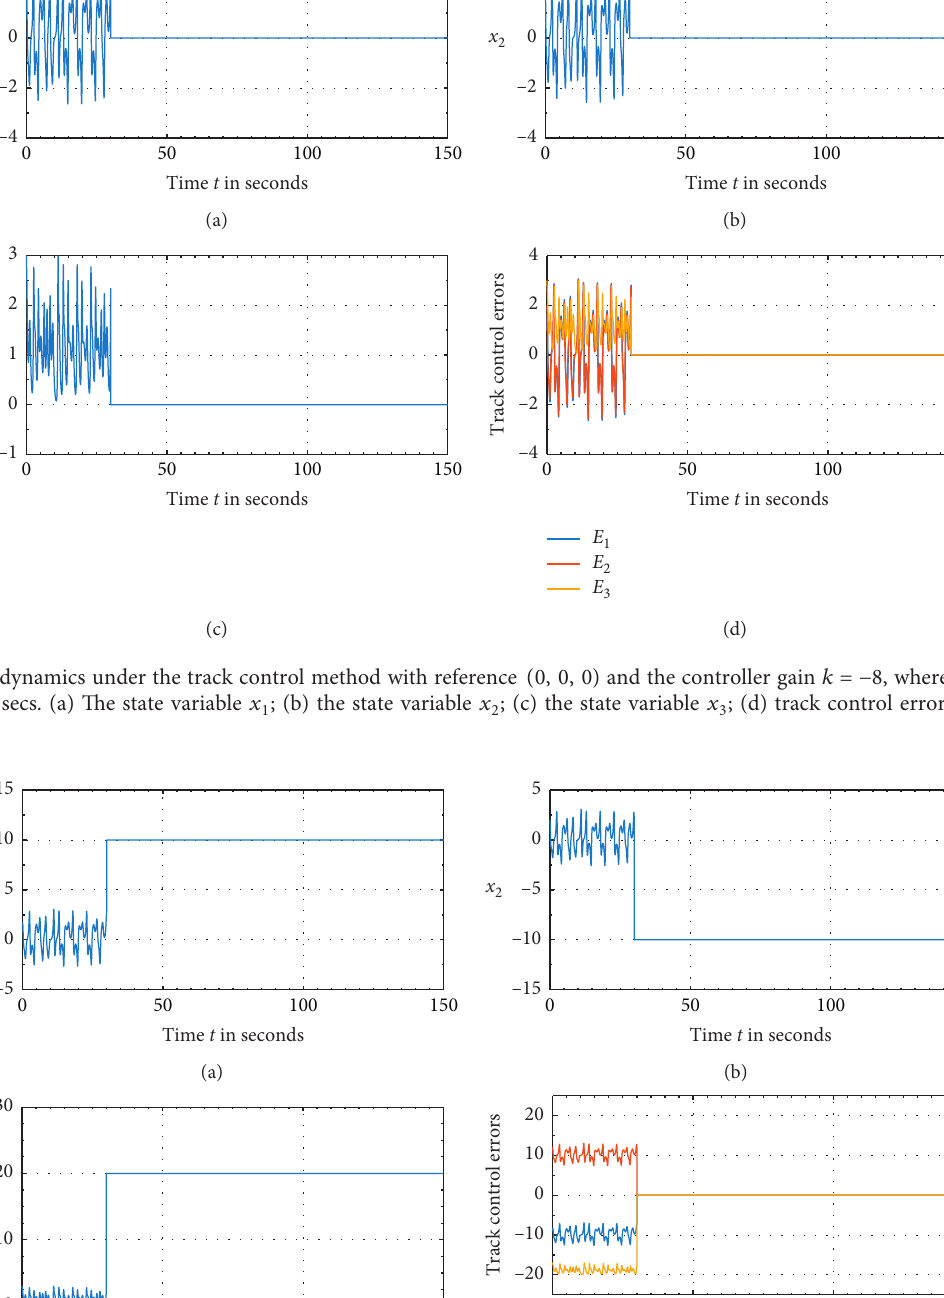
; (b) the state variable x 1